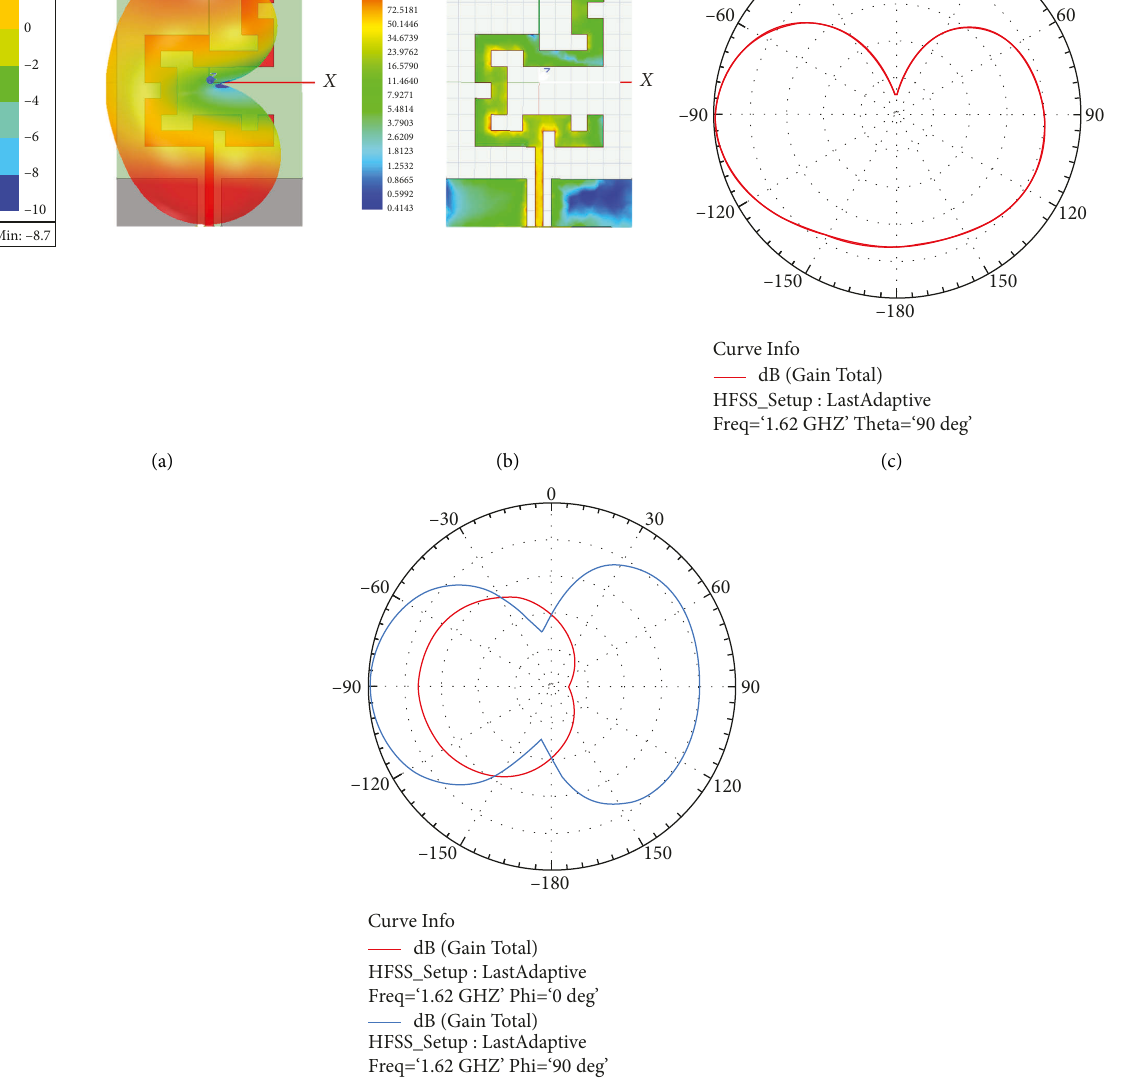
Figure 9. Due to the bending effect, the resonant length of the antenna usually changes, which further results in a small shift in the operating frequency of the antenna. Significant deviation from the measurement result under the normal flat orientation of the antenna is observed for the highest bending angle, θ � 162 . 34 ° since the rolling paper over